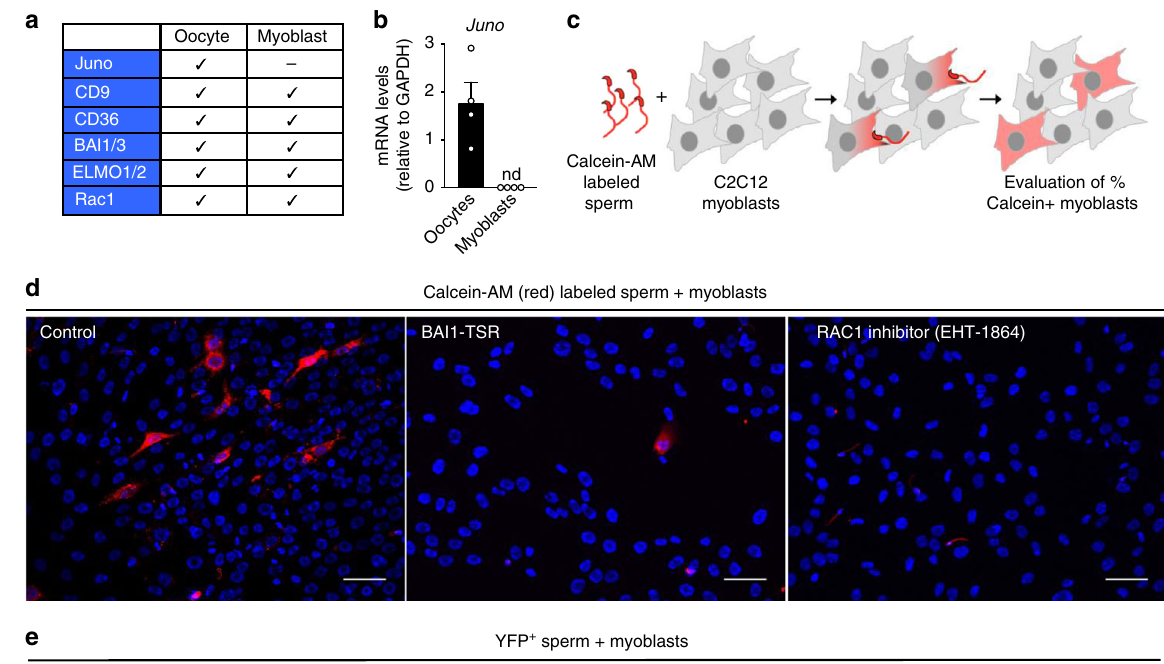
recognition receptors on the oocytes may work together with Juno in initiating intracellular signaling within oocytes, eventually leading to the critical step of gamete fusion. In summary, these data suggest that PtdSer on sperm and its receptors on oocytes as functional players that can work in conjunction with Izumo1 and Juno to promote sperm:egg fusion during